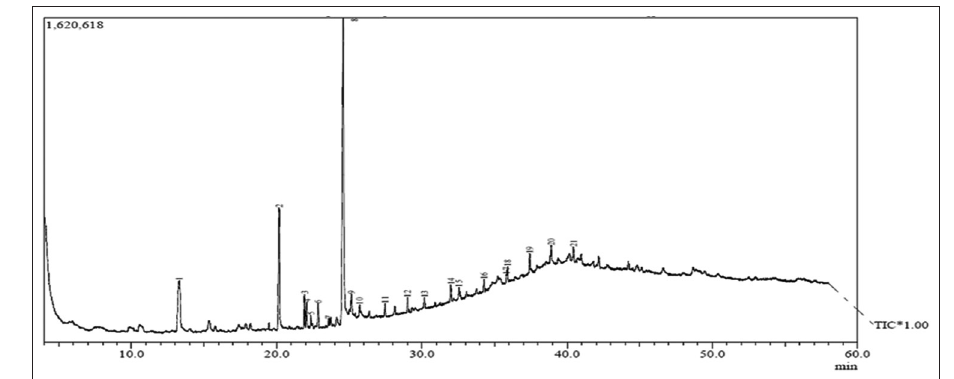
Molecular Compound name weight formula